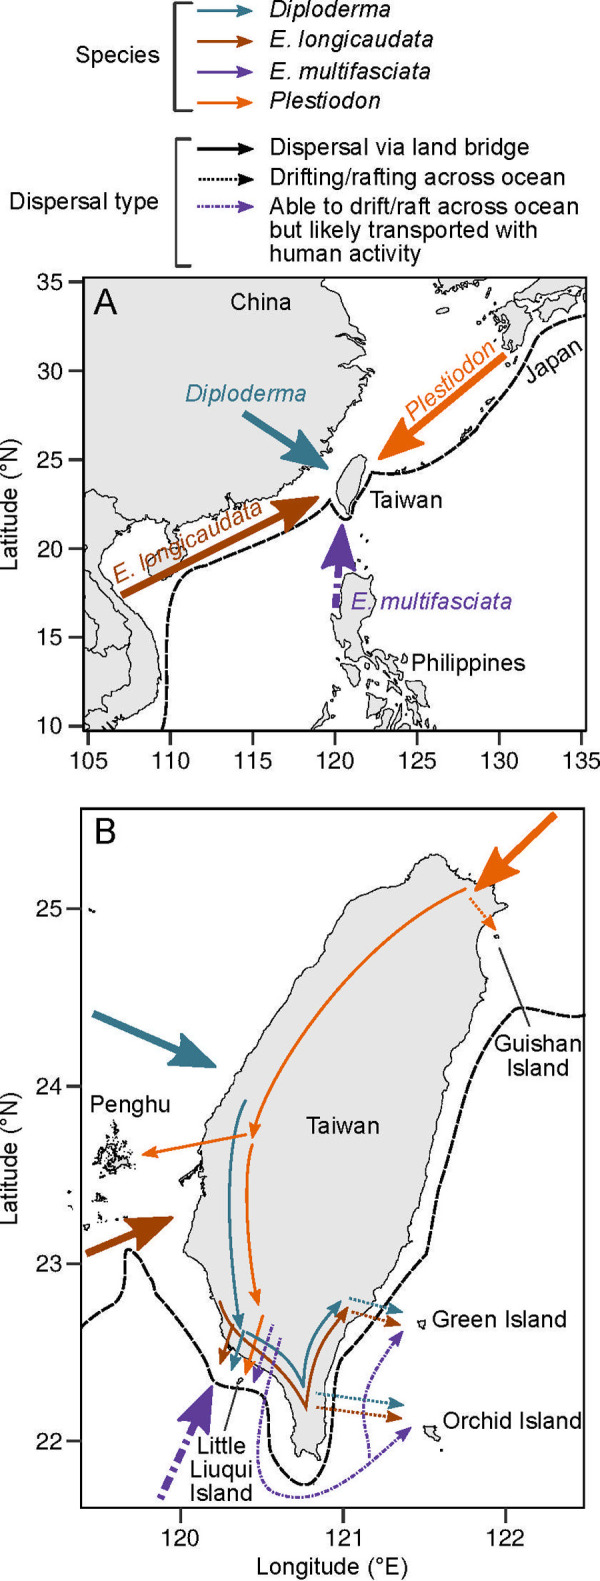
Dispersal routes of lizard four species in Taiwan.A. Dispersal routes to Taiwan. B. Dispersal route between Taiwan and the surrounding islands. The orange arrow represents the routes of Plestiodon [53]. The brown represents E. longicaudata [54]. The blue green represents Diploderma [55]. The purple dashed arrow represents the possible route of E. multifasciata. The solid arrows represent the possible dispersal routes on land. The dotted arrows represent the possible drifting/rafting routes across ocean. The black dashed line represents the coastline before 1.55 Ma. The coastlines were based on the open data from Natural Earth and Taiwan’s Ministry of the Interior, which were licensed under the Public Domain and the Open Government Data License (version 1.0; https://data.gov.tw/en/license), respectively.